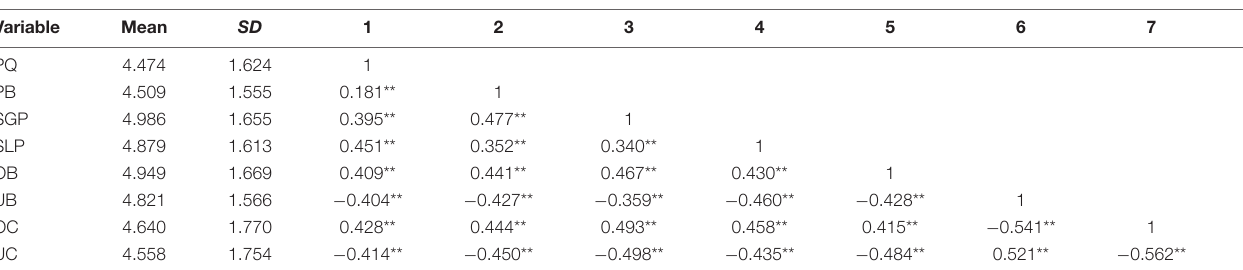
FIGURE 2 | Sample statistical distribution results. TABLE 2 | Correlation coefficient between